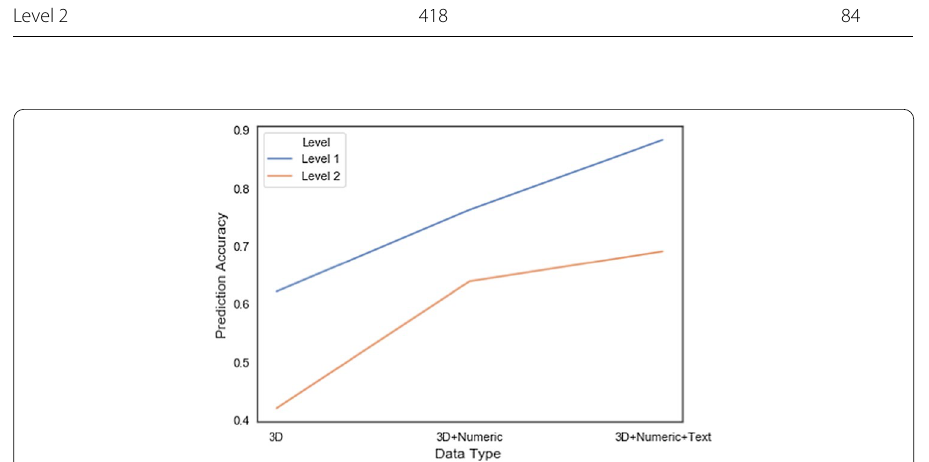
Fig. 13 Accuracy improvements with different input data